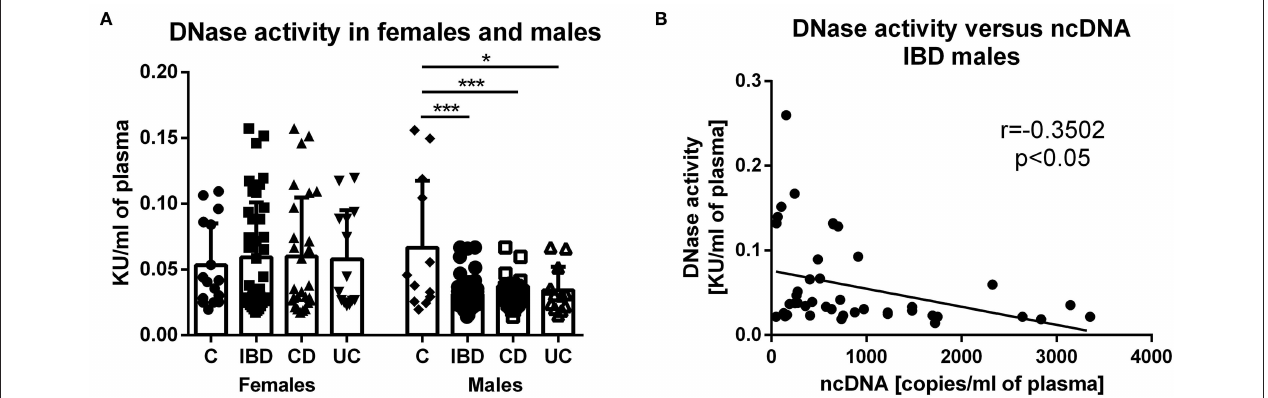
FIGURE 5 | DNase activity in healthy controls and patients. In females, no difference was found between groups. DNase activity was lower in male IBD patients ( p = 0.0001), including both CD ( p = 0.0002) and UC ( p = 0.0497) compared with healthy controls (A) . Negative correlation was found between DNase activity and concentration of ncDNA in male IBD patients ( p = 0.0198) (B) . * P < 0.05, *** P <